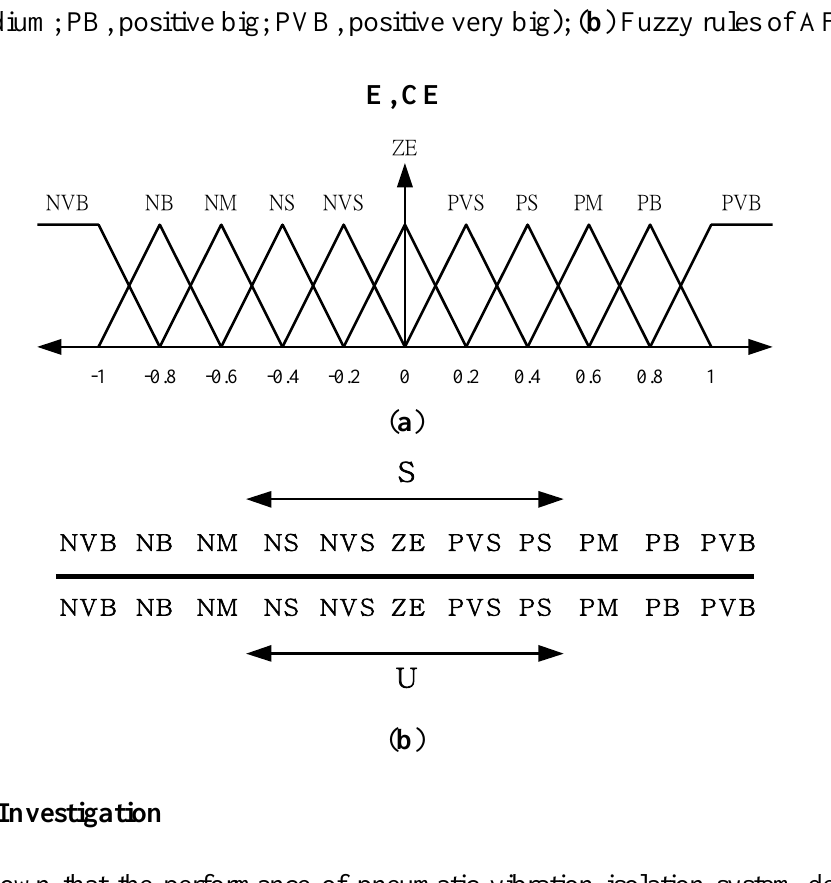
Figure 4. ( a ) Membership functions of the errors and error changes (Fuzzy partition with eleven terms: NVB, negative very big; NB, negative big; NM, negative medium; NS,